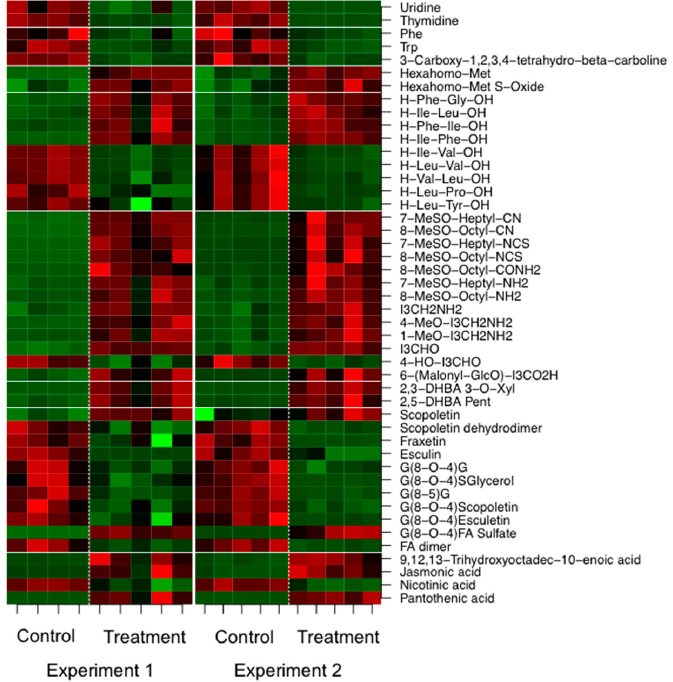
Figure 4. Differentially expressed metabolites ( p ≤ 0.01) in root exudates of A. thaliana after co-cultivation with the fungus P. indica for two weeks across two independent biological experiments. Intensity values were log-transformed and z-scored row-wise. Red: maximal intensity; Green: minimal intensity.